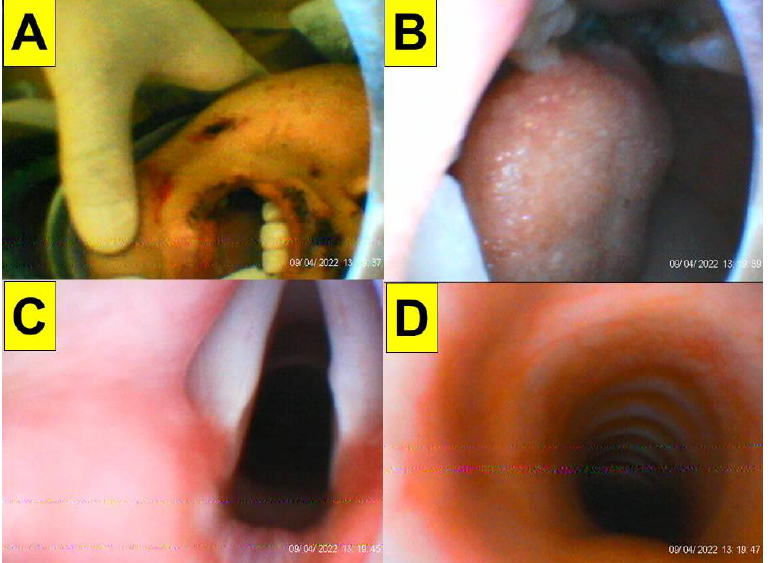
Figure 3. (Case 1) Close-up views during endotracheal intubation using the video-assisted